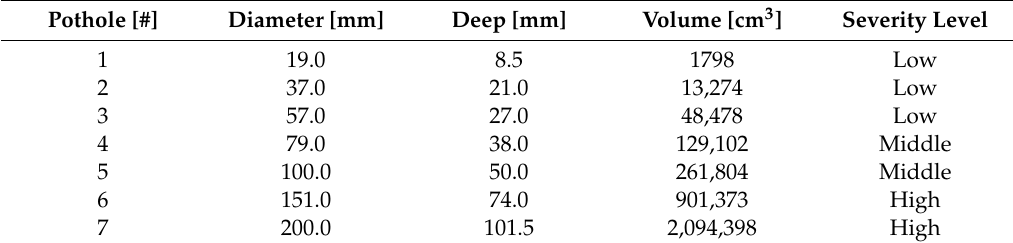
Table 1. Characteristics of studio surface potholes.